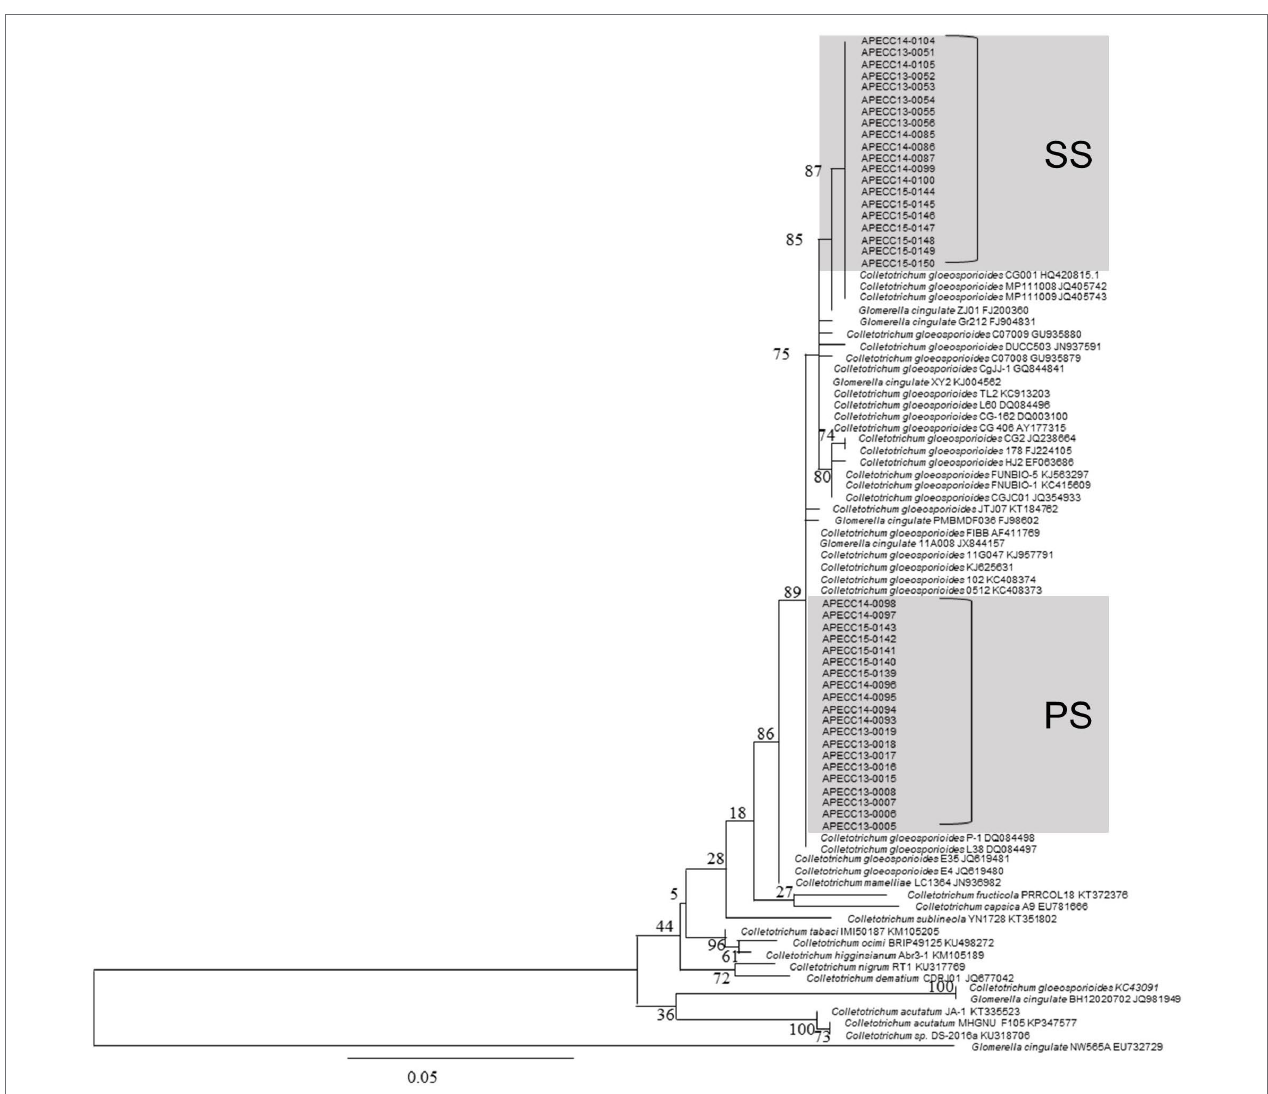
FIGURE 2 | The phylogenetic tree of internal transcribed spacer (ITS) sequences of 40 isolates of C. gloeosporioides along with other isolates of Colletotrichum spp. from NCBI was inferred using the maximum likelihood method (MEGA 7.0). The percentage of replicate trees in which the associated taxa clustered together in the bootstrap test (100 replicates) is shown below the branches. The scale bar indicates 0.05 substitutions per nucleotide